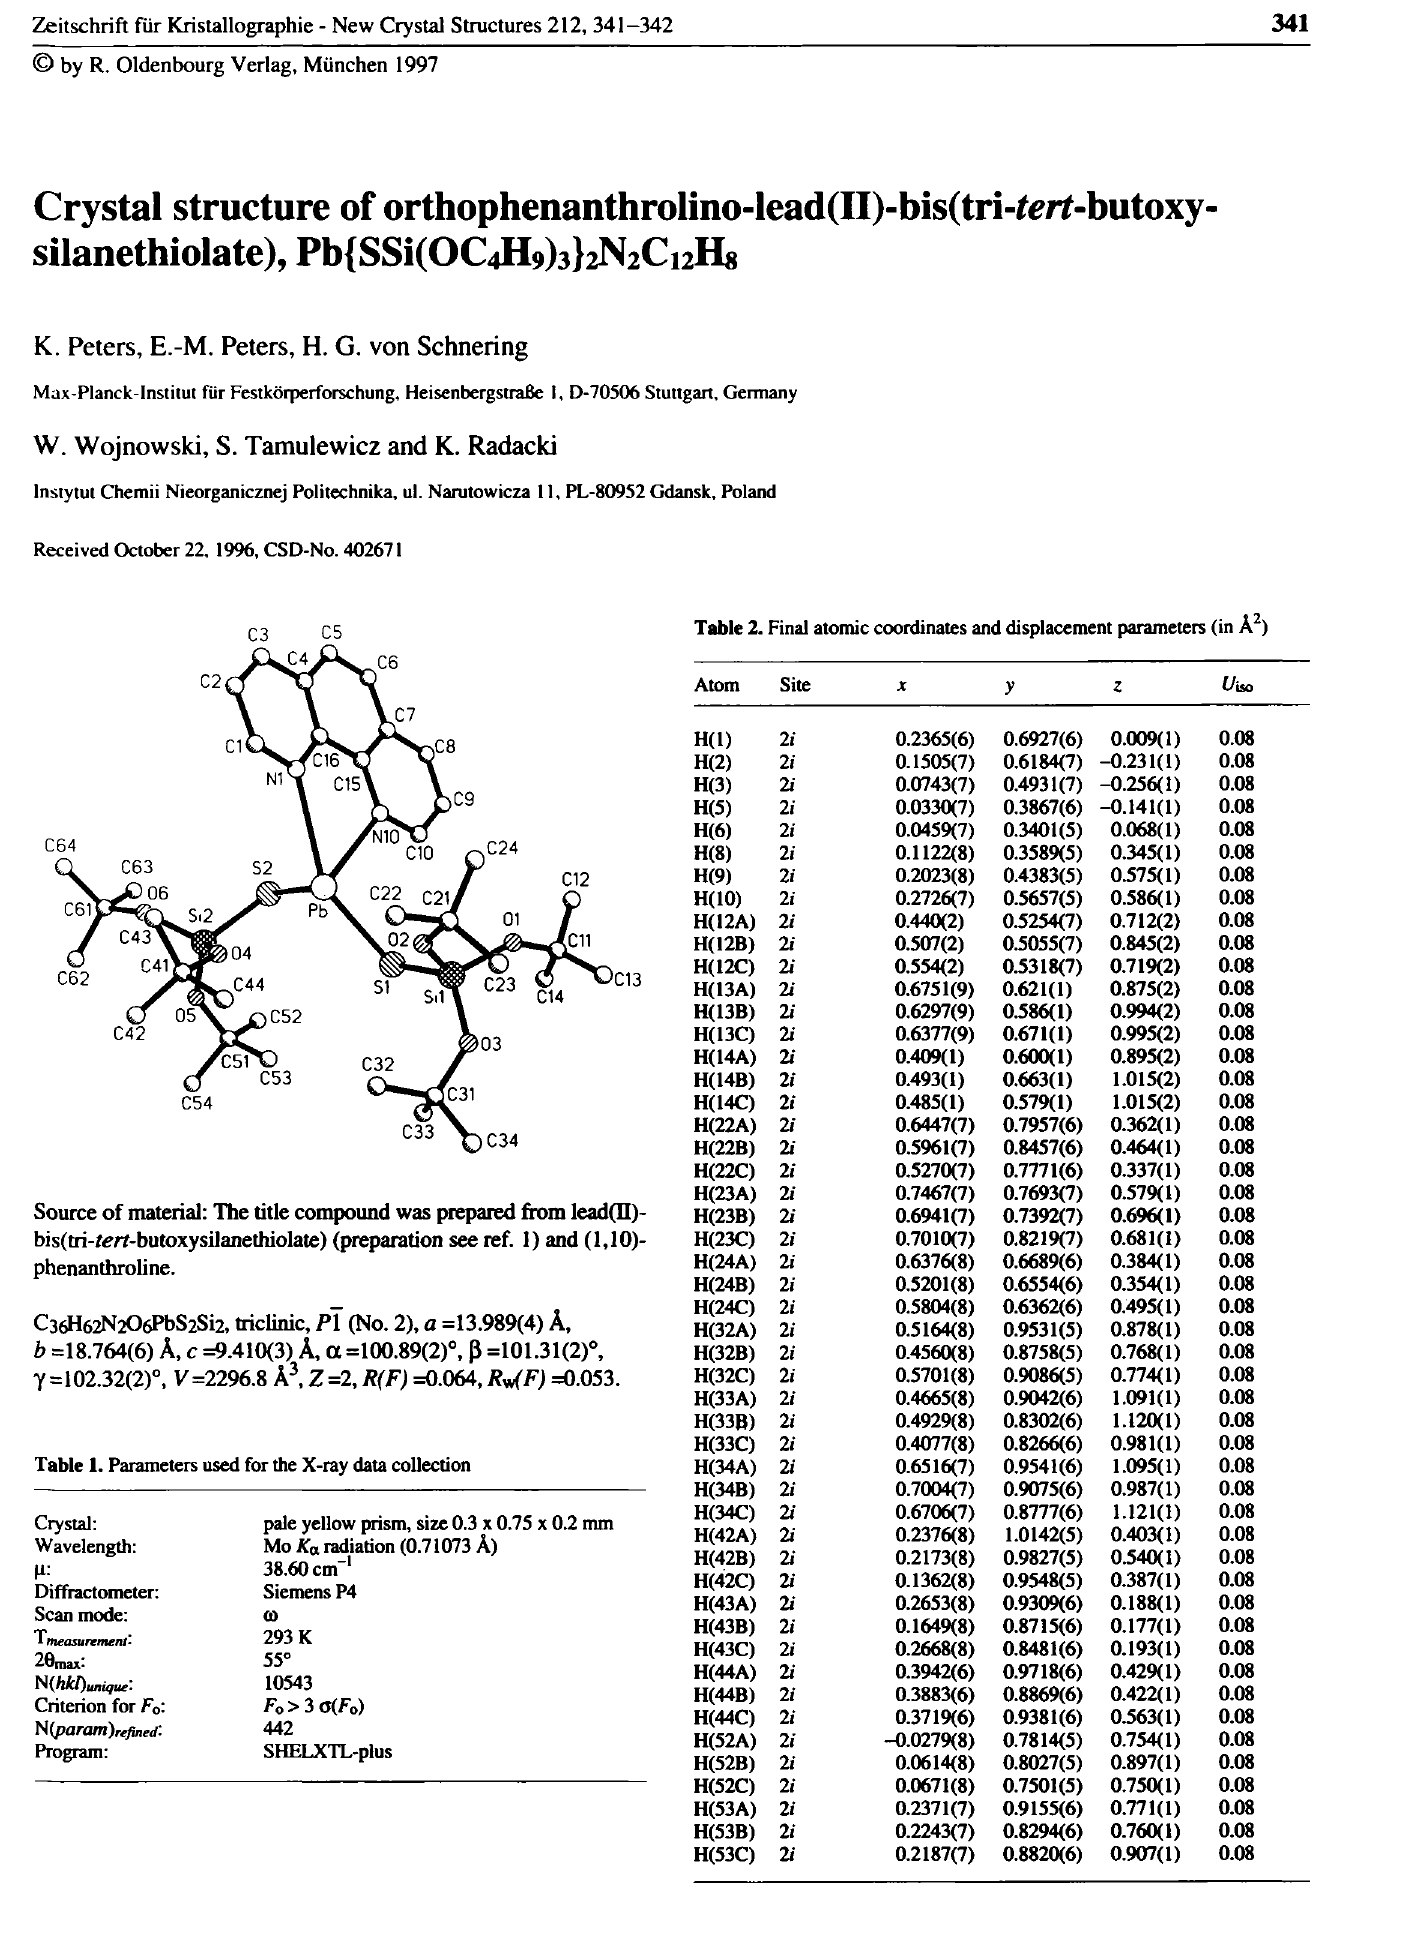
Table I. Parameters used for the X-ray data collection Crystal: